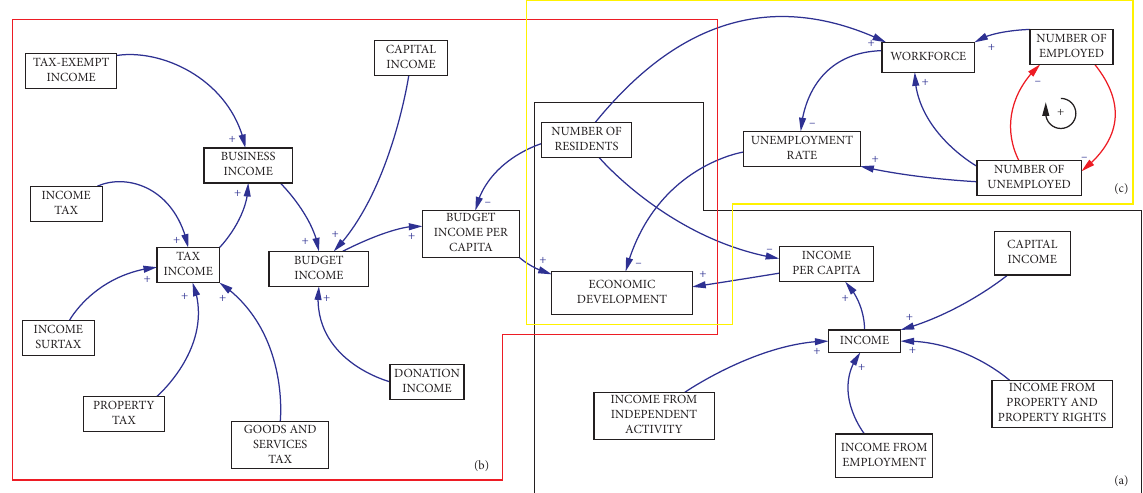
Figure 2: Structure of feedback loops (causal loop diagram) in the system of economic development